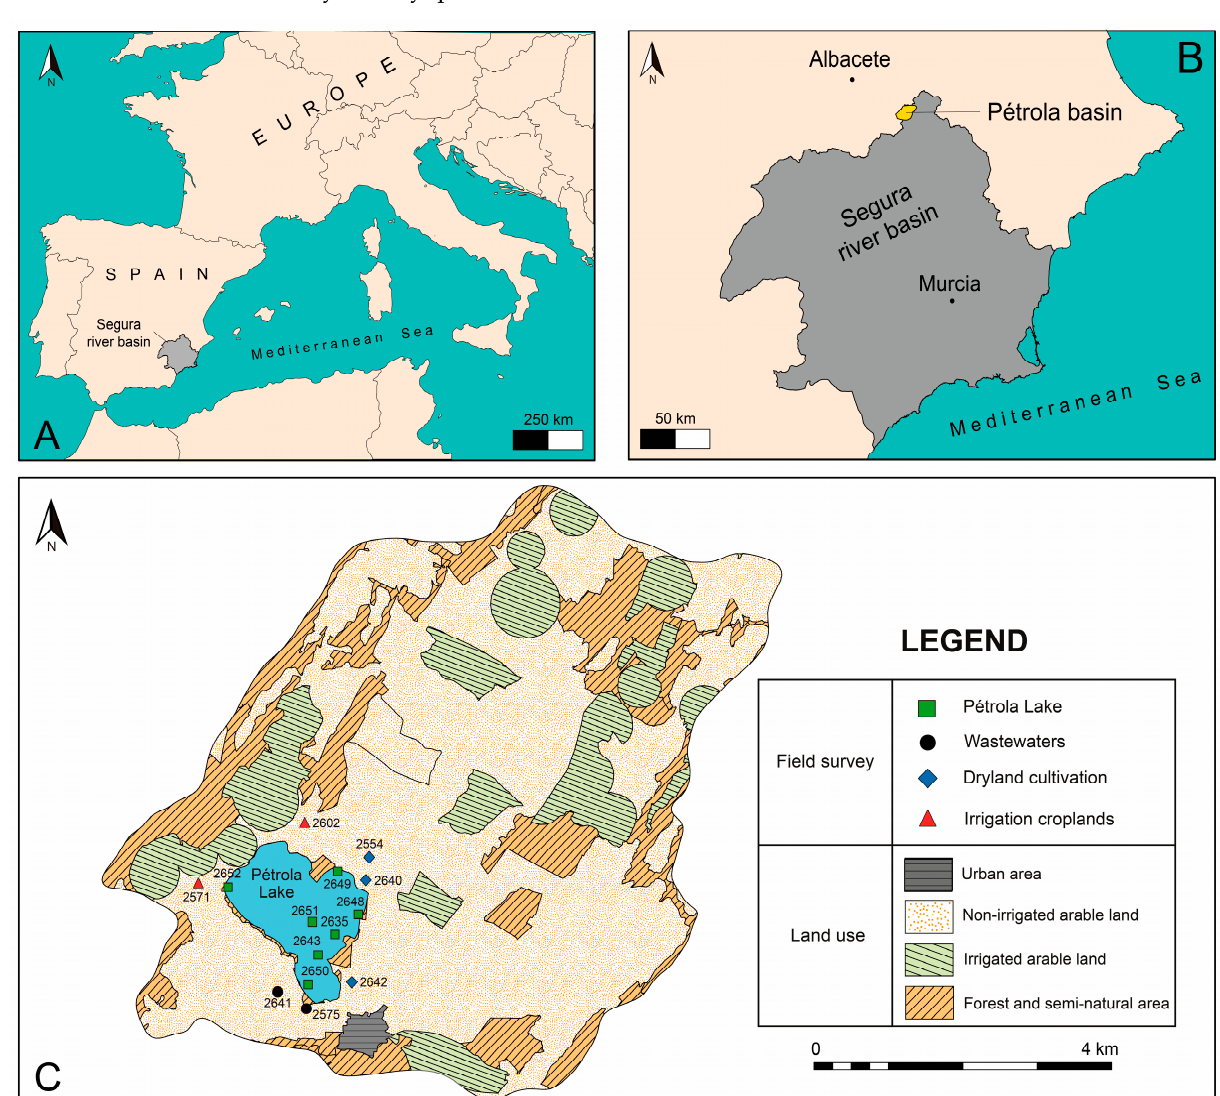
Figure 1. ( A ) Location of the Segura river basin in Europe. ( B ) Location of P é trola basin in Segura river basin. ( C ) Land use map of P é trola basin and location of control points from the studied areas: P é trola Lake (green squares), affected by wastewaters (black circles), dryland cultivation (blue rhombus), and irrigated croplands (red